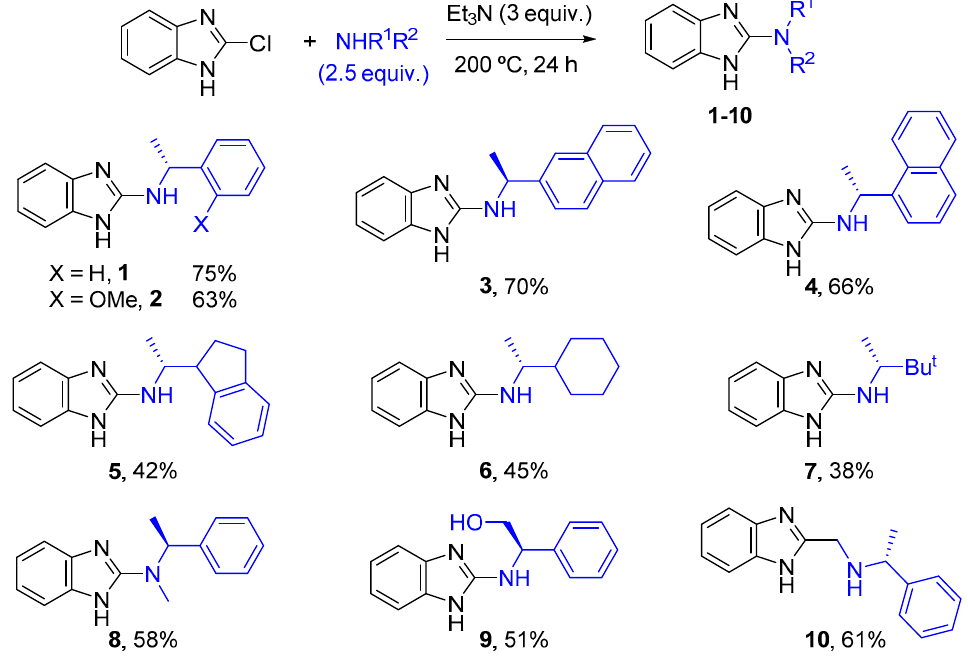
Figure 2. Synthesis of chiral organocatalysts.